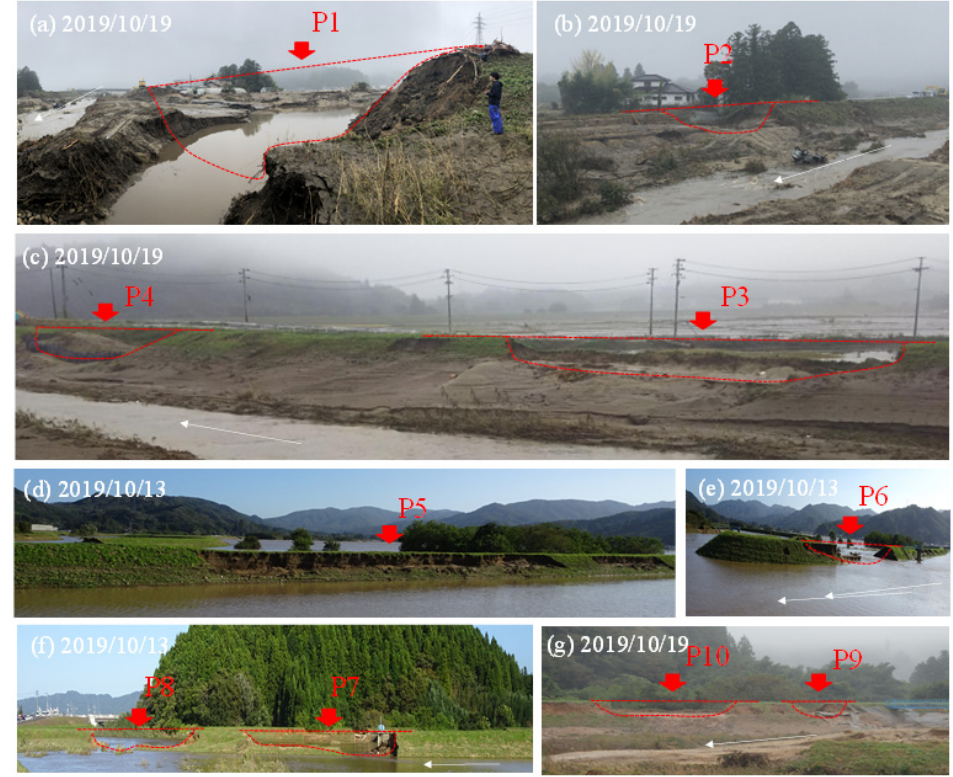
Figure 12. Post-event photographs of levee breaches at corresponding locations from the P1 to P10 in Figure 11 along the Uchi, Gofukuya, and Shin